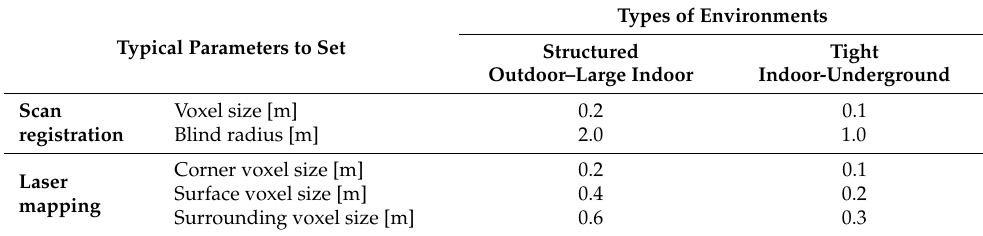
Table 2. Parameters setting for the mapping system (Kaarta Stencil